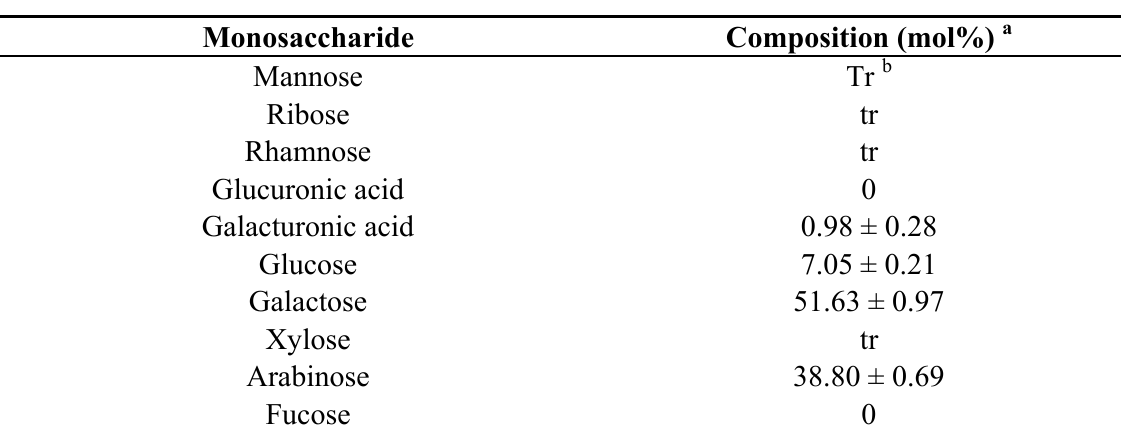
Table 6. Monosaccharide composition (mol %) of hydrocolloid extracted from tamarillo puree (TH water